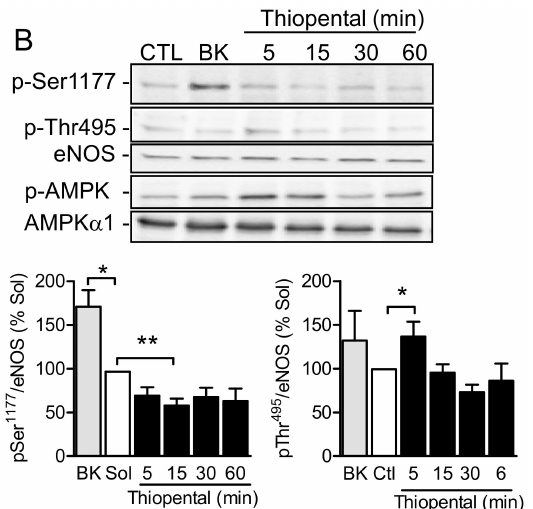
Figure 5. Effect of AMPK activation on eNOS activity and phosphorylation. Cultured human endothelial cells were incubated with solvent (Sol), thiopental (1 mmol/L, 5–60 min), or bradykinin (BK; 1 µ mol/L, 2 min). Thereafter, the phosphorylation of ( A ) AMPK and ( B ) phosphorylation of eNOS at Ser1177 and Thr495 were assessed. Bar graphs summarize the data obtained in four to five different cell batches; * p < 0.05, ** p < 0.01 versus solvent treatment.